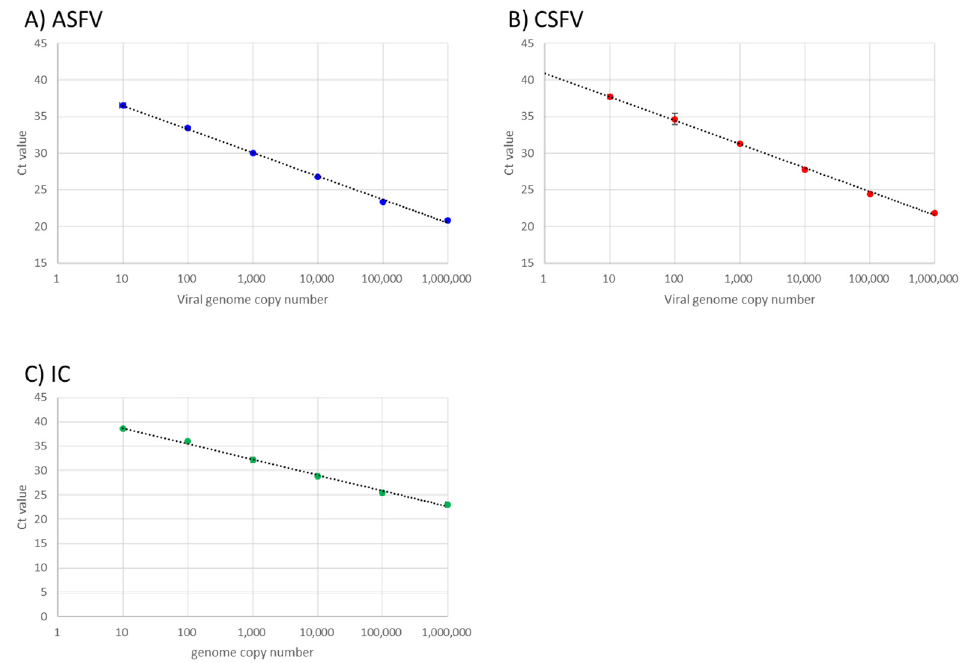
Figure 1. Analytical sensitivity of the developed multiplex real-time reverse transcription (rRT)-PCR for African swine fever virus (ASFV), classical swine fever virus (CSFV), and internal control (IC) detection. Serial dilutions of CSFV/ASFV positive control DNA (Takara Bio Inc.) containing artificial templates of ( A ) ASFV, ( B ) CSFV, and ( C ) porcine GAPDH (IC) were amplified using the newly developed multiplex rRT-PCR system.